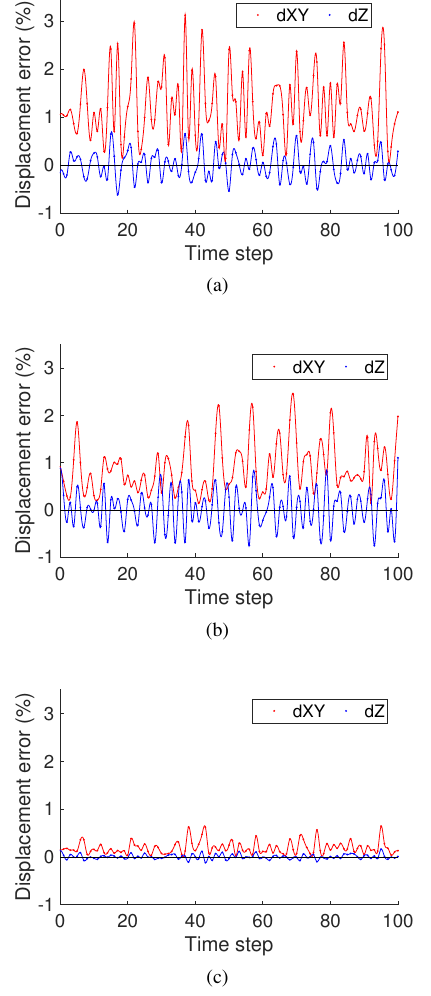
Figure 5. Coordinate displacement error (percentage of water depth) obtained from 100 runs of the simulation tool with a flying height of 500m, (a) horizontal water surface, (b) tilted water surface point density 3 points per square meter (p/m 2 ), (c) tilted water surface point density 10 p/m 2 .